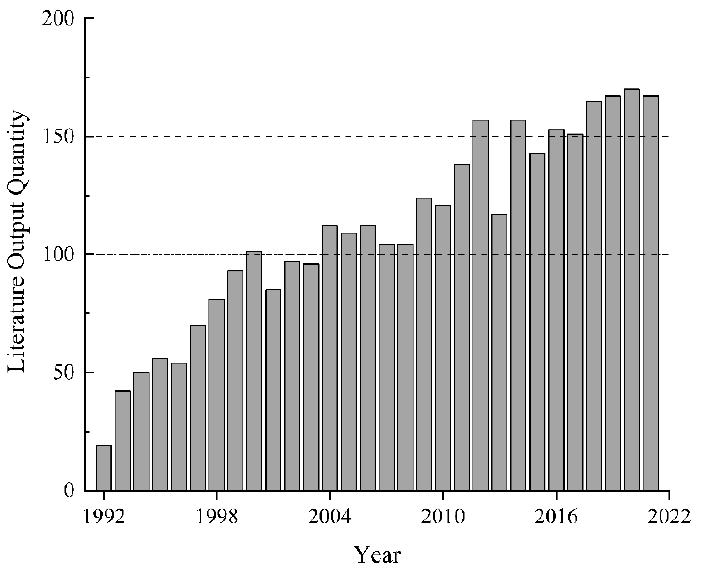
Figure 2. Quantity of literatures on preferential flow retrieved from WoS core collection database (1992 to 2021).